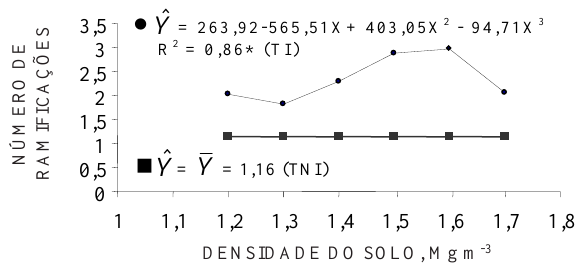
Figura 2. Número de ramificações da parte aérea de plantas de cajueiro anão precoce, cultivadas em colunas de solo com tratamentos térmicos; isolado (TI) e não isolado (TNI), considerando a densidade do